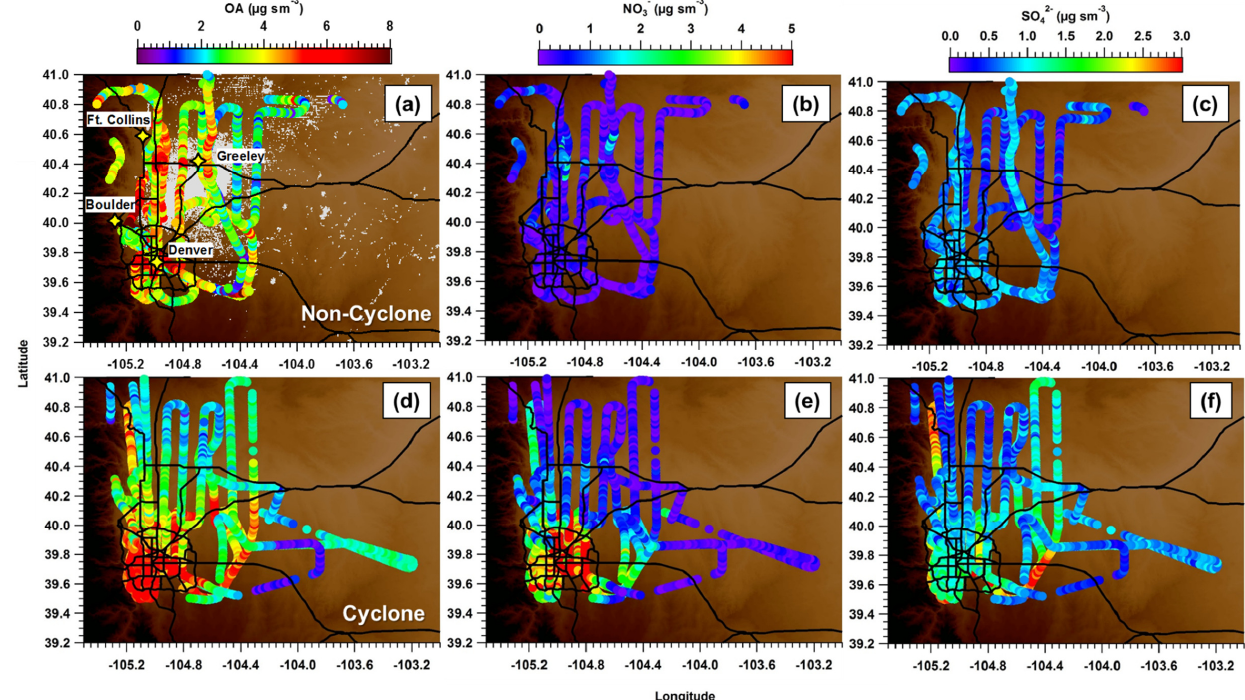
Figure 6. Spatial distribution maps along the C130 flight track of aerosol species (OA, NO − the non-cyclone (a–c) and cyclone episodes (d–f) . Major highways are shown with black lines, and grey markers in (a) represent the location of active oil and gas wells in the region with data available from the Colorado Oil and Gas Conservative